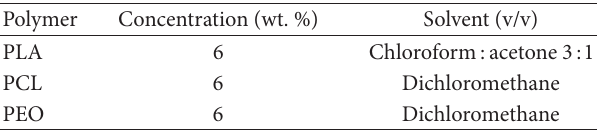
Table 1: Solution parameters of spun fibers. Polymer Concentration (wt.